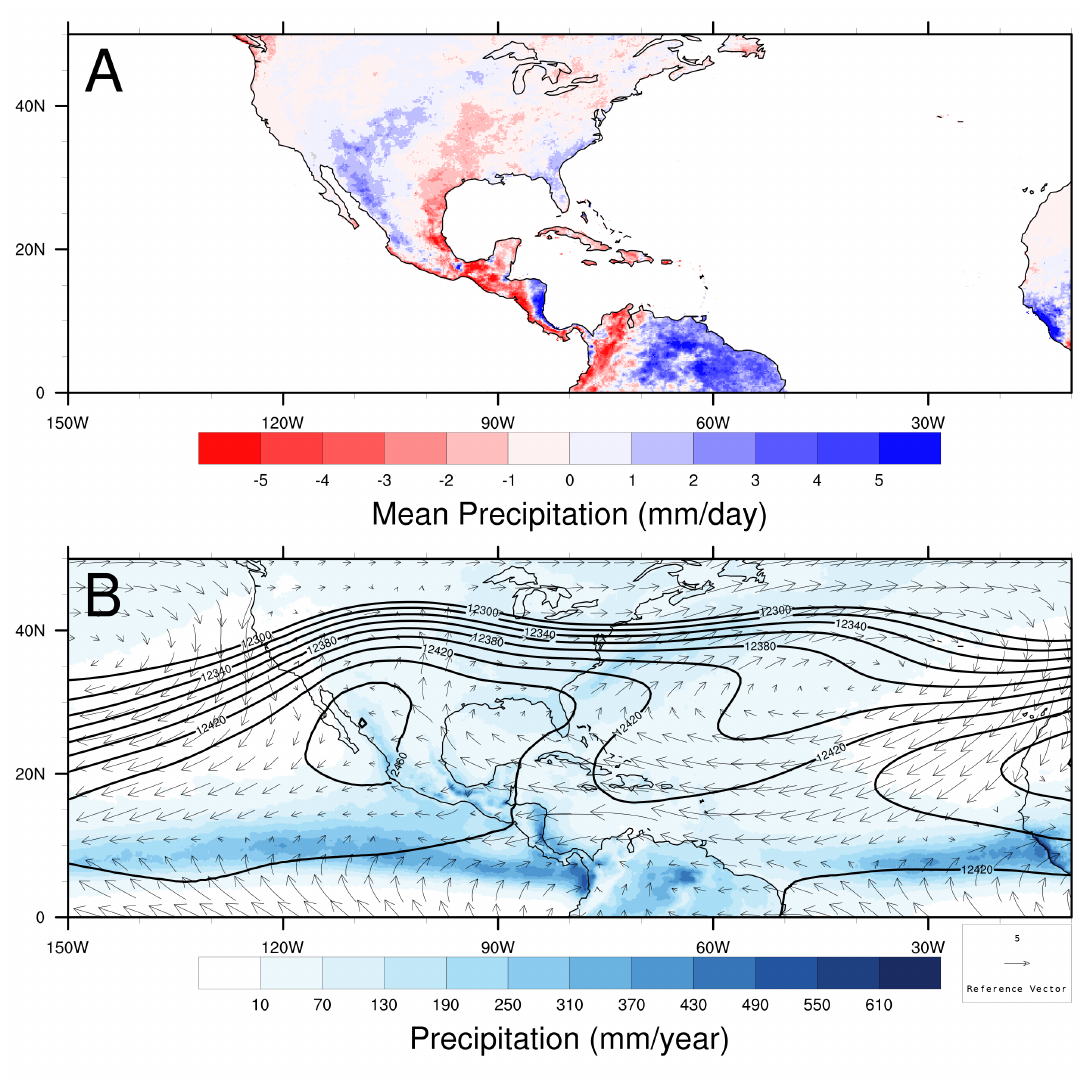
Figure 7. ( A ) Averaged accumulated precipitation for the difference WT 5 − WT 1 highlighting the dry spell in August over southeast Mexico and Central America. Note that precipitation fields in ( A ) for WT 5 are constructed using days in August and correspondingly, WT 1 uses days in September as presented in Figure 3. ( B ) Accumulated annual precipitation from CHIRP (color shades), wind vectors at 925 hPa and geopotential height at 200 hPa (contours 12,304 to 12,474 by 20 m). Data plotted in ( B )